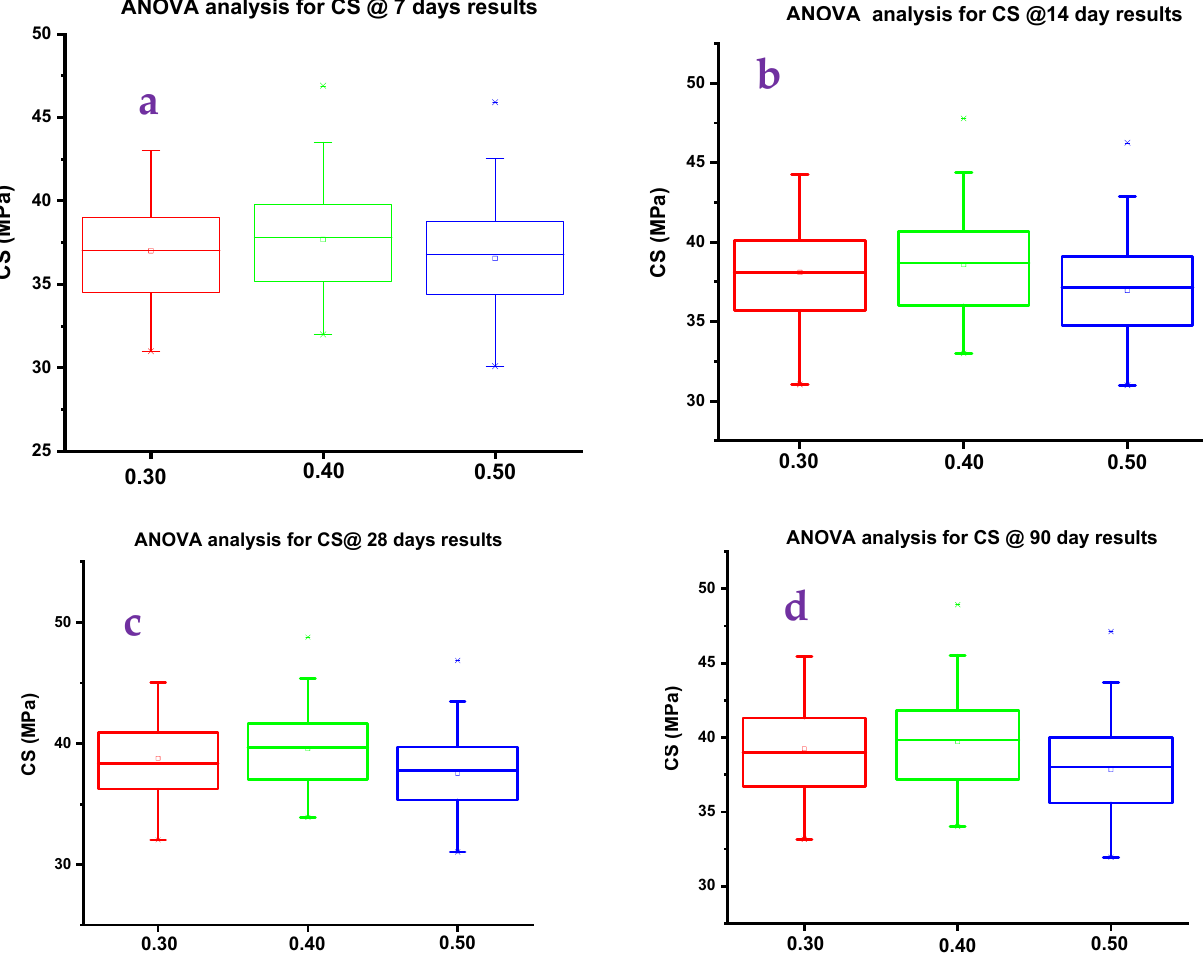
Figure 12. ANOVA analysis for various CS results of ( a ) 7 days, ( b ) 14 days, ( c ) 28 days, and ( d ) 90 days. Similarly, the probability factor was 0.9067, 0.7676, and 0.9069 for 14, 28, and 90 days of testing, respectively. Levene and Tukey ′ s variation analysis showed an average probability of 92%, which indicates that the CS results line varies linearly. For an A/B ratio of 0.40, results show that CS results vary linearly for a testing period of 7 to 90 days. As the curing days progressed, the CS strength also increased. A 2 to 3% increment of CS value was observed from 7 to 14 days of testing for an A/B ratio of 0.40. For 28 and 90 days of testing, the variation of CS results for A/B ratios was 1 to 1.5% increment. The presence of RM as the binder in GPC showed incremental CS results, but for specimens tested for 28 and 90 days, the CS value increment was only marginal. Figure 13 shows the radar plot in line pattern (a) and area plot (b). GR6 shows the maximum CS value among all the mixes for an A/B ratio of 0.40 (refer to Figure 13b).